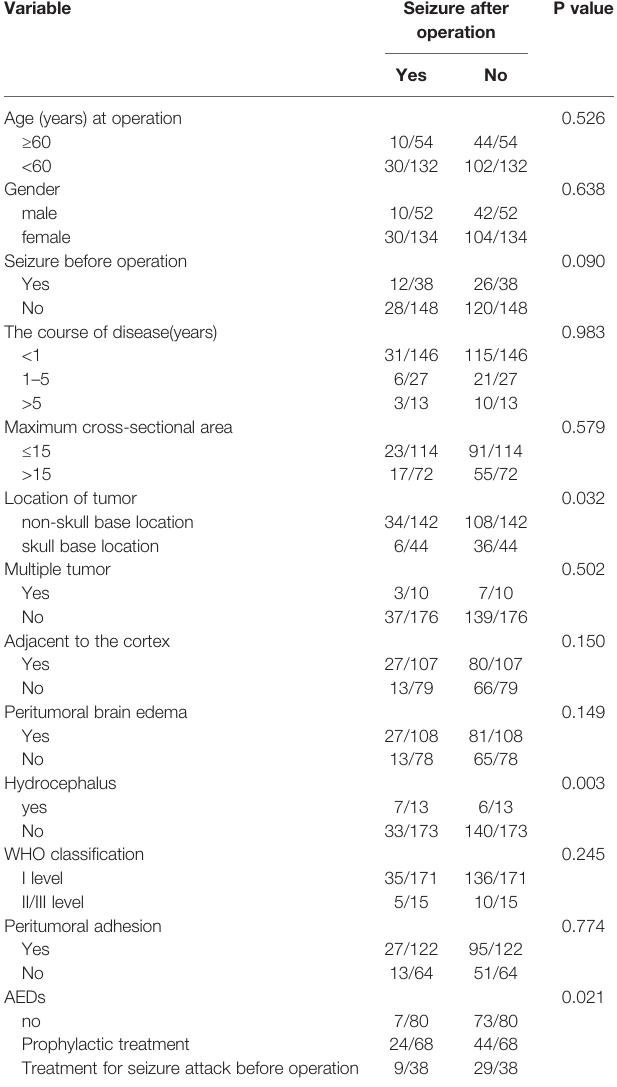
TABLE 1 | Baseline characteristics of participants. Variable Seizure after